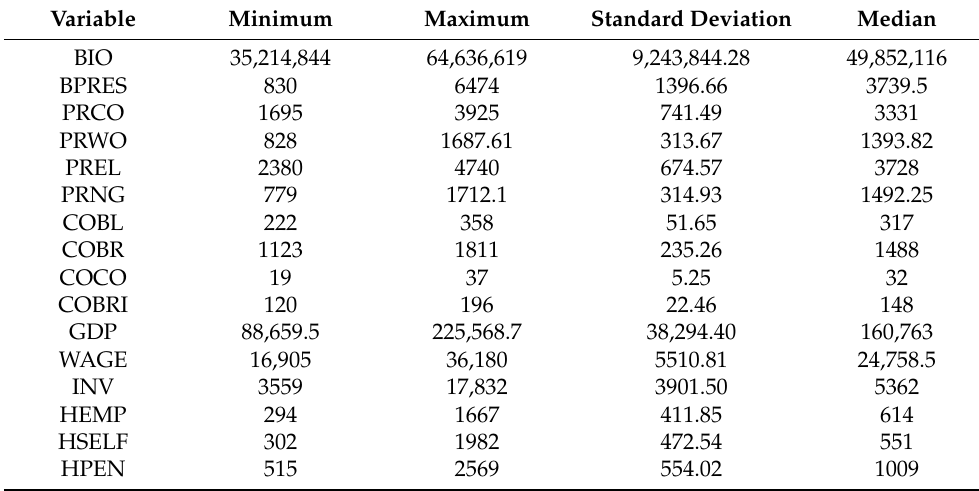
Table 3. Overview of the data